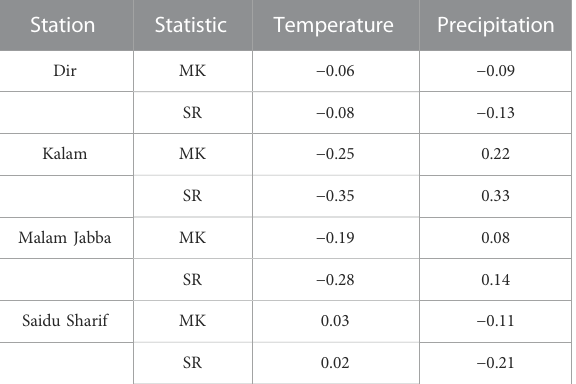
TABLE 2 Results of Man-Kendall and Spearman ’ s rho tests at 5% signi fi cance level.